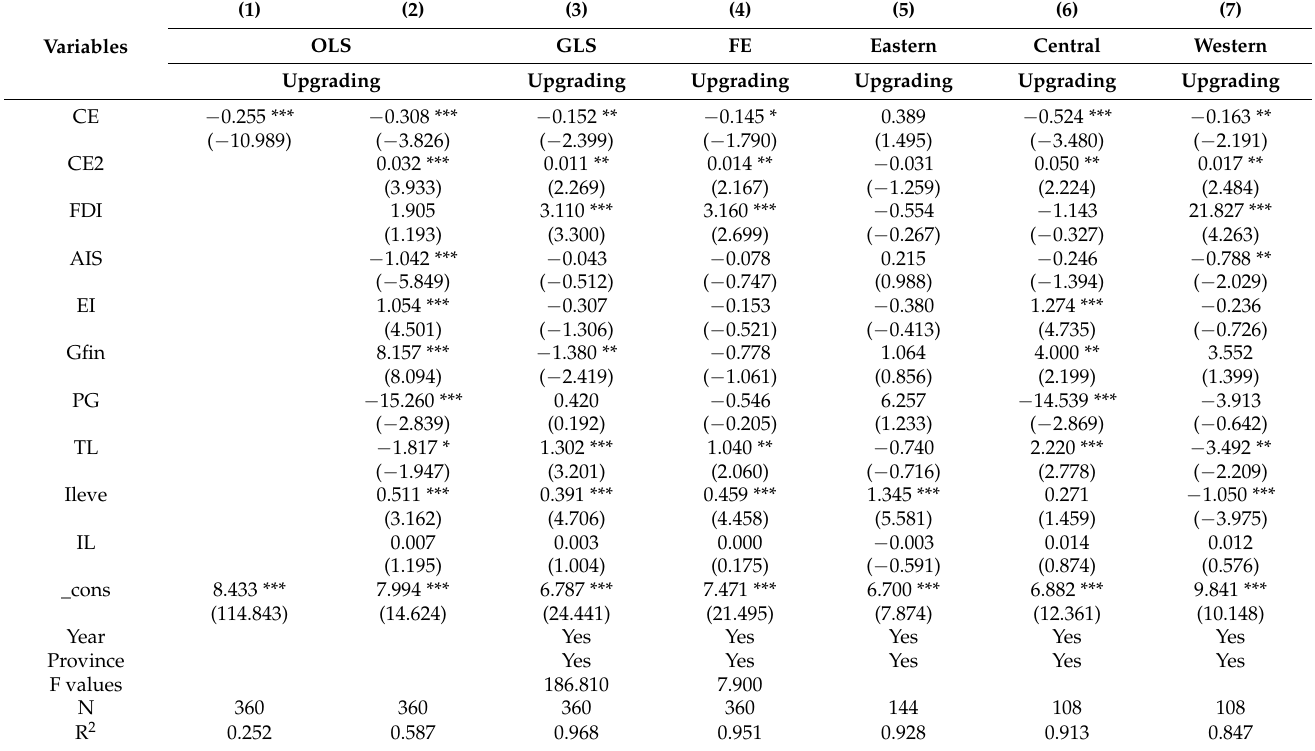
Table 3. Benchmark regression